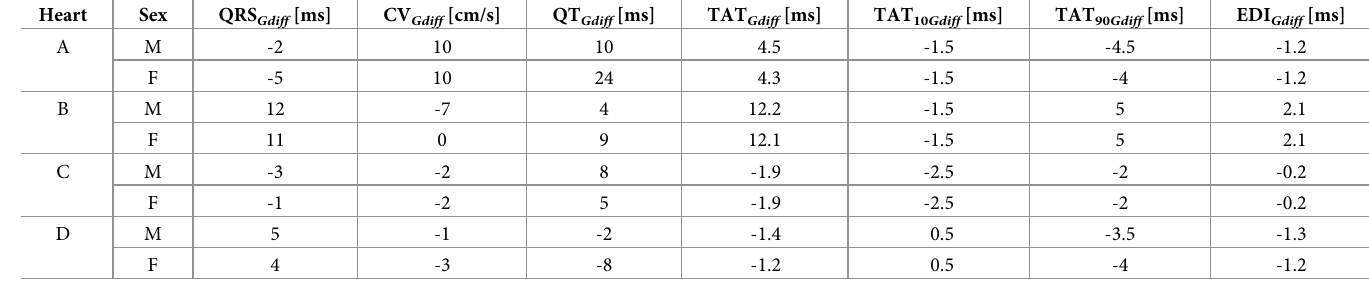
Table 5. Electrophysiological simulation results. Quantification of differences between detailed and smoothed geometries. Markers are shown as the difference between the detailed minus the smoothed